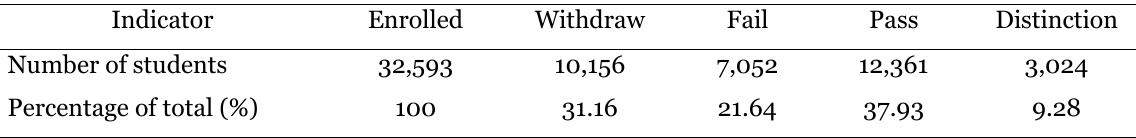
Global View of Enrolment and Academic Results Indicator Enrolled Withdraw Fail Pass Distinction Number of students 32,593 Percentage of total (%) 100